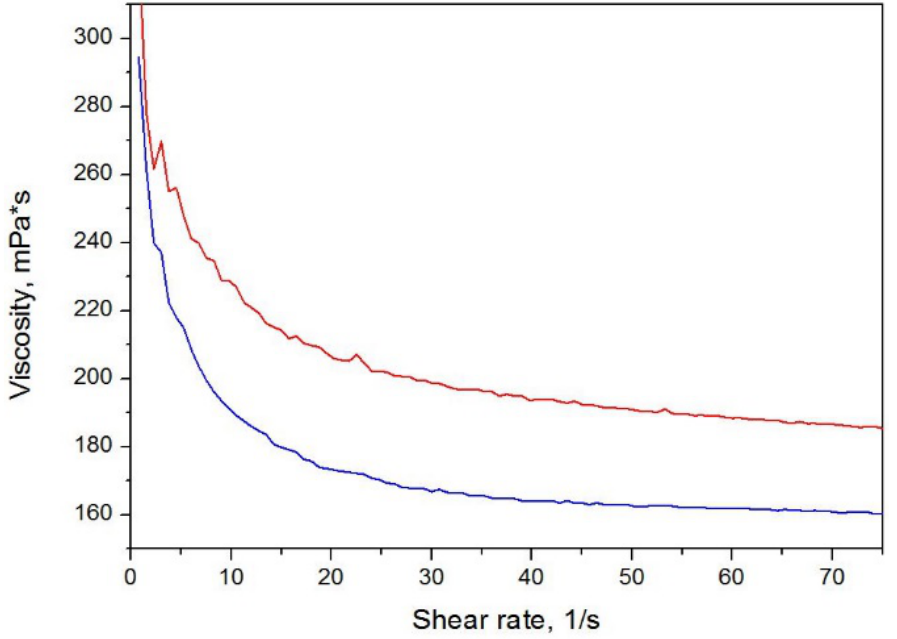
Figure 4. Dynamic viscosity as a function of shear rate for pastes in the absence (blue graph) and in the presence of the pore former (red graph); * is a multiplication sign in the viscosity unit. Based on the printing tests carried out at different frequencies and print head valve opening times, the optimum mode for inkjet printing of 3D objects was selected. Thus, a